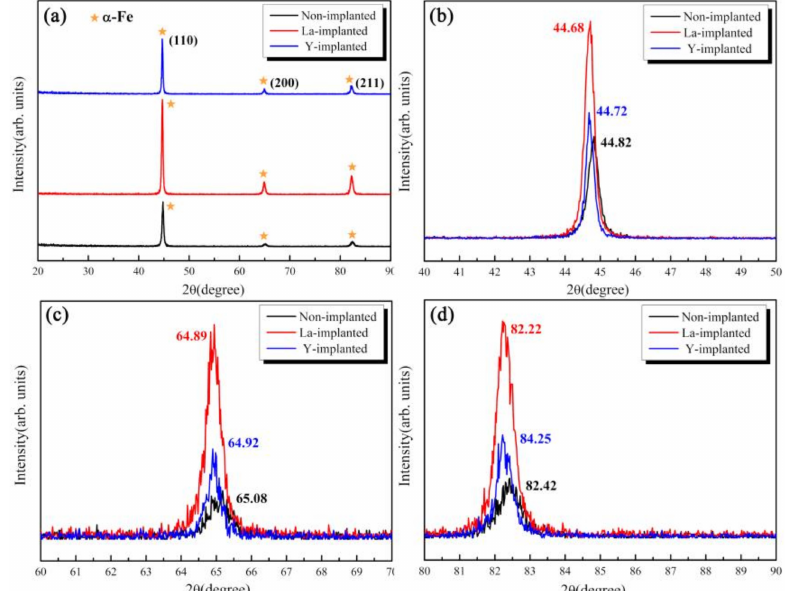
Figure 6. XRD patterns of the implanted surface with and without rare earth (RE) implantation—( a ) XRD spectra; ( b ) di ff raction angle of the (110) peak; ( c ) di ff raction angle of the (200) peak; and ( d ) di ff raction angle of the (211) peak.